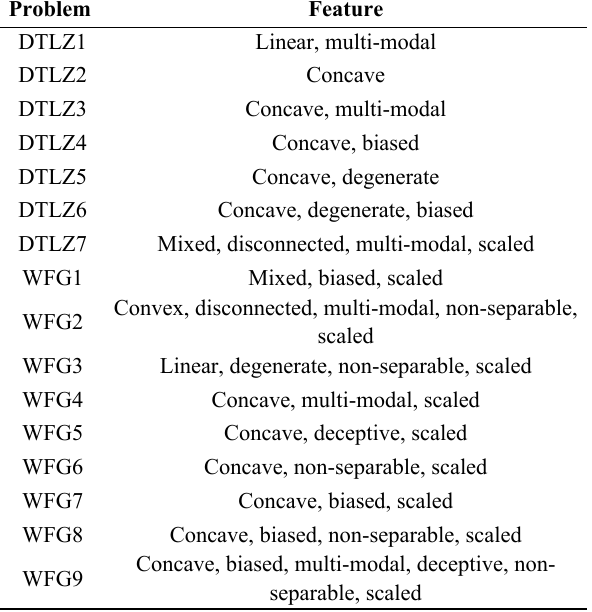
Table 1 Characterization of test instances DTLZ1−DTLZ7 and WFG1−WFG9.